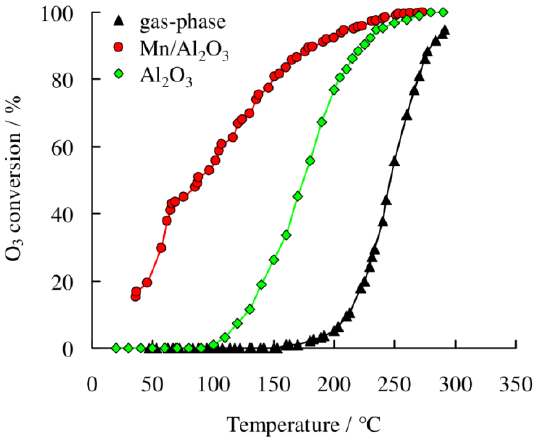
Figure 5. The gas-phase and catalytic O 3 decomposition. Conditions: 450 ppm O 3 , balanced with N 2 ; F total = 750 mL/min (GHSV = 155.000 h − 1 ).